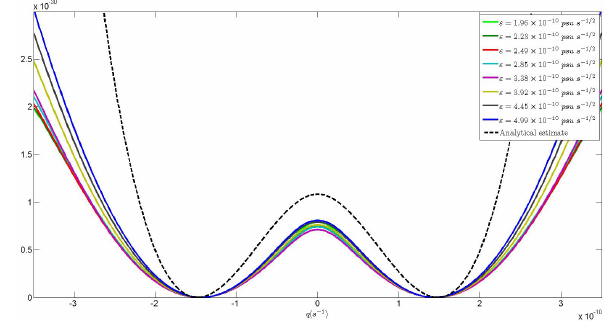
Fig. 8. Goodness of the one-dimensional approach for the full Fig. 9. One-dimensional efficient potential V eff (q) controlling the model. (a) Average rate of hopping between the northern and south- evolution of the THC strength in the 5 d.o.f. model with symmetric ern sinking equilibria r( +→− ) = r( −→+ ) (black line). The the- noise. The results of some numerical experiments are shown to- oretical value is shown with the red line. Data are in units of s − 1 . gether with the analytical estimate. The results are rather similar to (b) Geometrical factor G( +→− ) = G( −→+ ) of the hopping rate what shown in Fig. computed from Eq. (7). Adimensional quantity. (c) Value of the pa- rameter γ giving the ratio between ε eff (obtained as a divided by b ) √ and the theoretically derived expression 2 kβε . The value of γ ob- tained if considering the renormalized value (referred to the 2 d.o.f. model) for k can be read on the right hand side scale. Adimensional quantities.